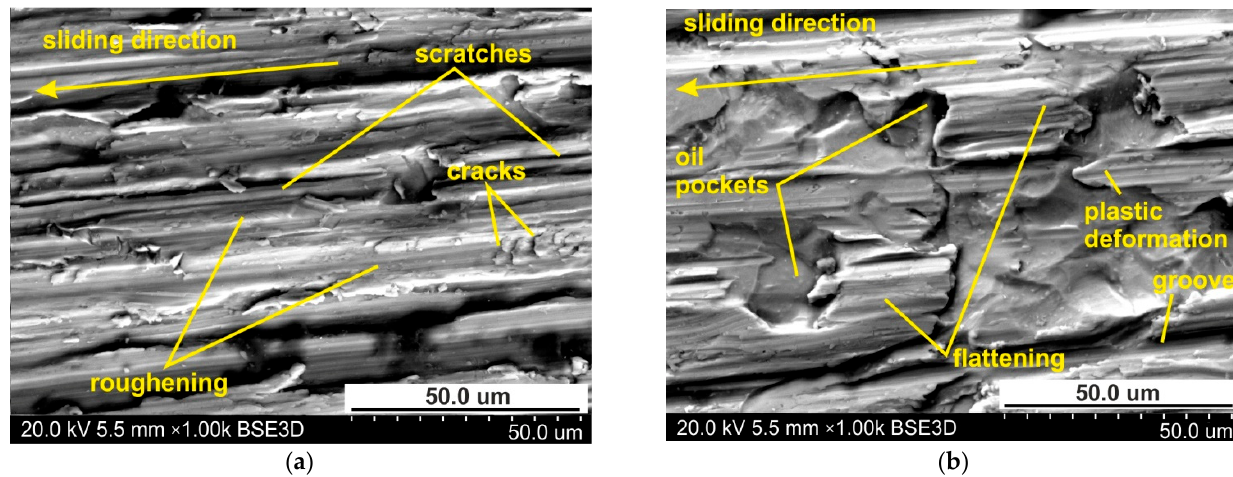
Figure 11. The specimen surfaces tested at 114 MPa in ( a ) dry friction and ( b ) lubricated conditions using machine oil L-AN 46.